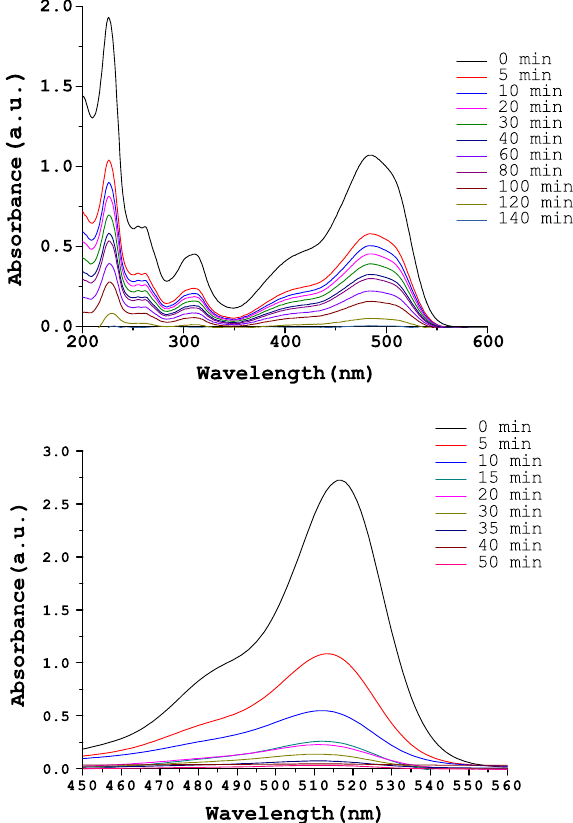
Figure 7. Time dependent UV–Visible spectra of Orange (II) and Eosin Y solutions with SF@GOC